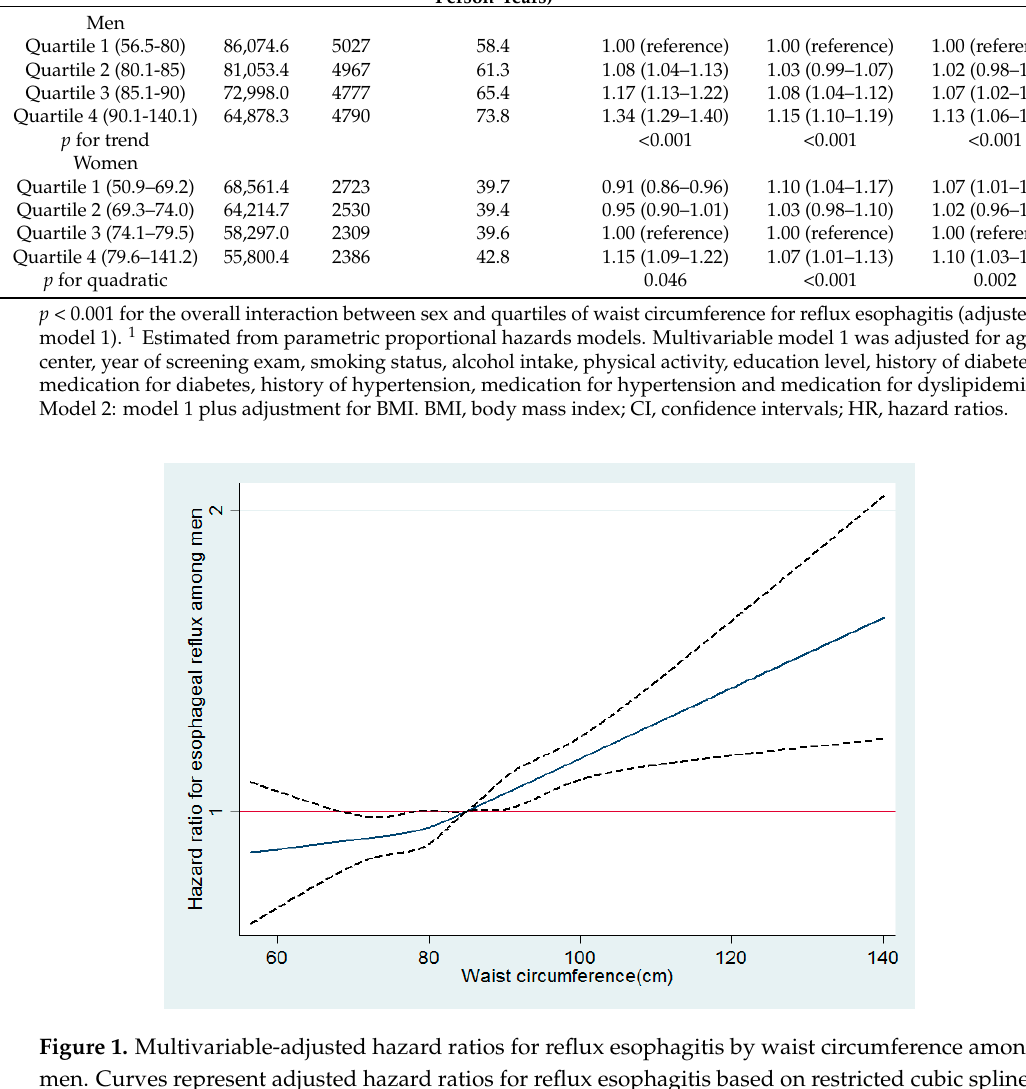
Table 3. Development of reflux esophagitis according to waist circumference quartiles by sex. Quartiles of Waist Circumference (cm)